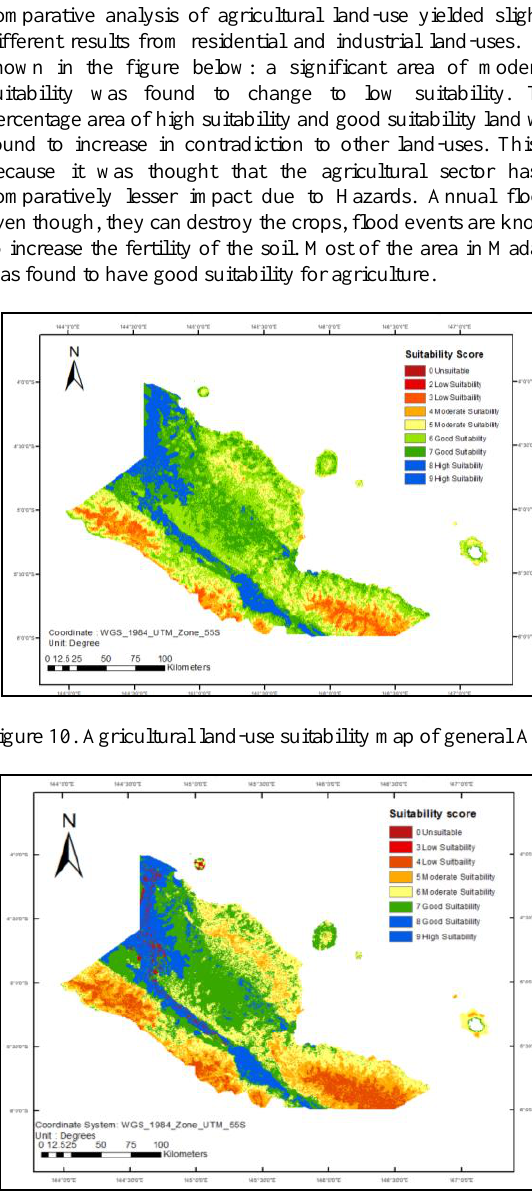
Figure 11. Agricultural land-use suitability map of Multi-hazard AHP Table 3. Agricultural land-use coverage for different degree